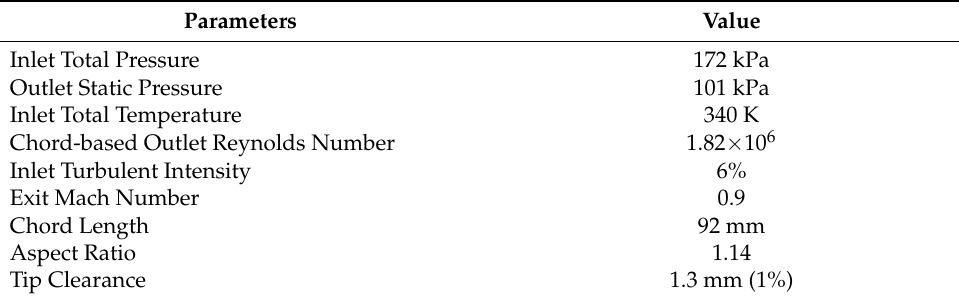
Figure 1. Test blade loading for two-dimensional design and three-dimensional near tip region (97% span). Table 1. Boundary Conditions and Geometry